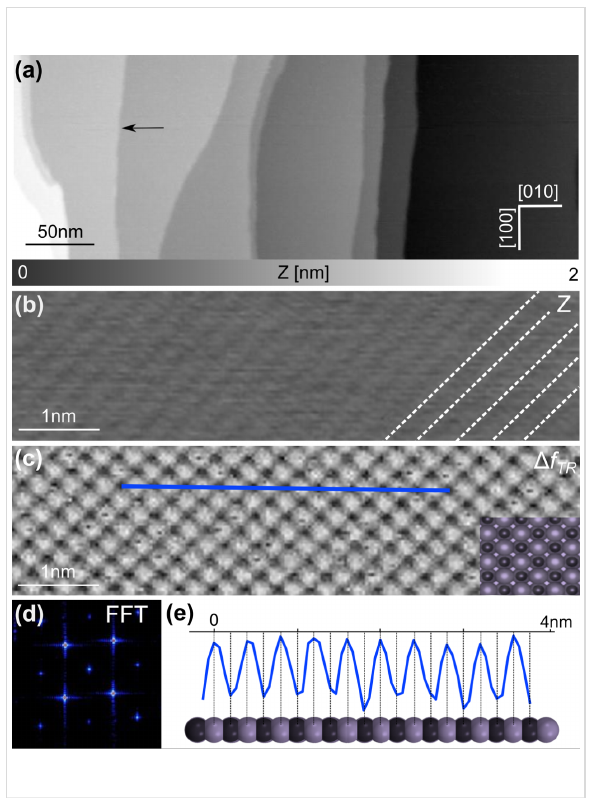
Figure 2: From large-scale imaging to atomic resolution on NiO(001). (a) Large scale topographic image of the NiO(001) crystal presenting clean terraces (scan parameters: = 4 nm, Δ f 1 = − 30 Hz). The high- resolution topographic image (b) shows the atomic rows while the torsional frequency shift (c) indicates that only one kind of atom can be imaged: one element appears as bright protrusion, the other as darker hole (scan parameters: = 7 nm, = 80 pm, Δ f 1 = − 79 Hz). (d) Fast Fourier transform (FFT) of (c) shows the expected cubic packing of the crystal. (e) Profile acquired along the dark blue line visible in (c). The spacing between the atoms (410 pm) corresponds well to the theoretical bulk lattice constant of NiO(001): a = 417 pm.